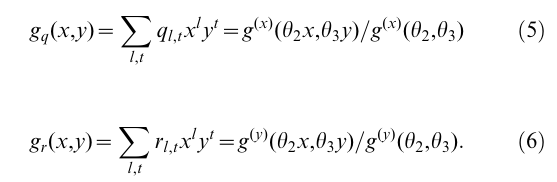
PLoS Computational Biology |